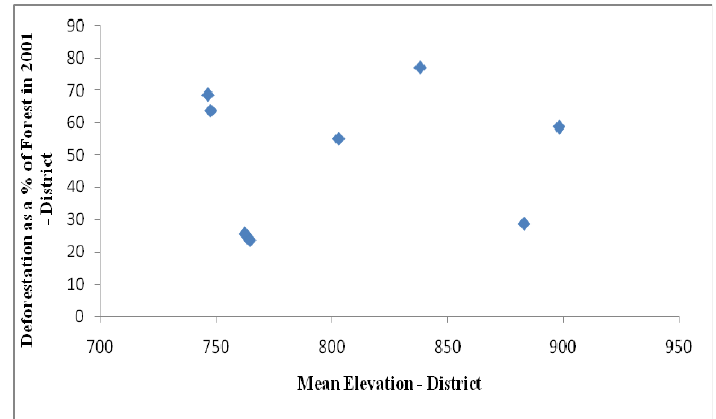
Figure 10a. Relationship between mean elevation and the distribution of deforestation as a percentage of the forest area existing in 2001, for